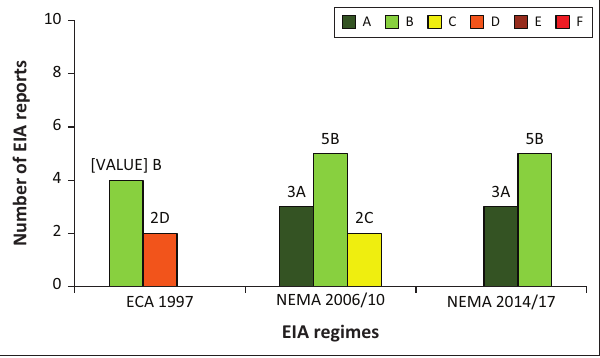
FIGURE 4: Overall quality across Environmental Impact Assessment